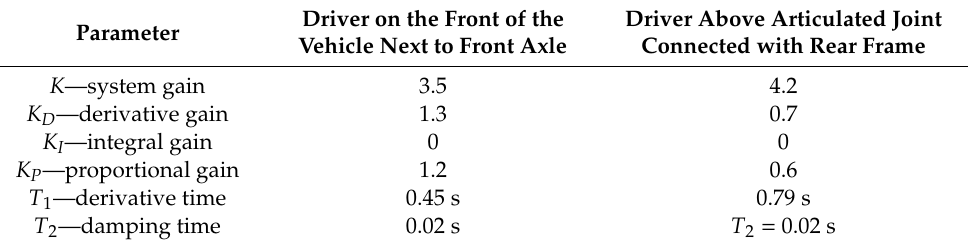
Table 2. Parameter of Anticipative Driver Model.